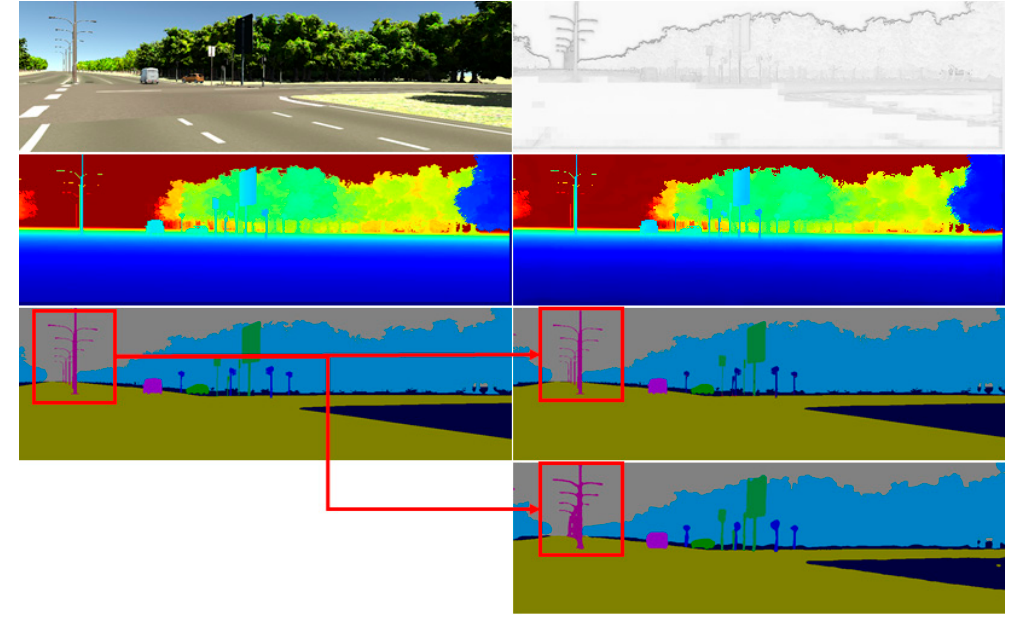
Figure 4. The SSDNet experimental results on Virtual KITTI. In an order of top-down: the first column shows the RGB color image, the depth ground truth and the semantic segmentation ground truth; the second column shows the boundary-similarity result, the depth completion output, the semantic segmentation result, and corresponding BaCNN [20] result respectively.